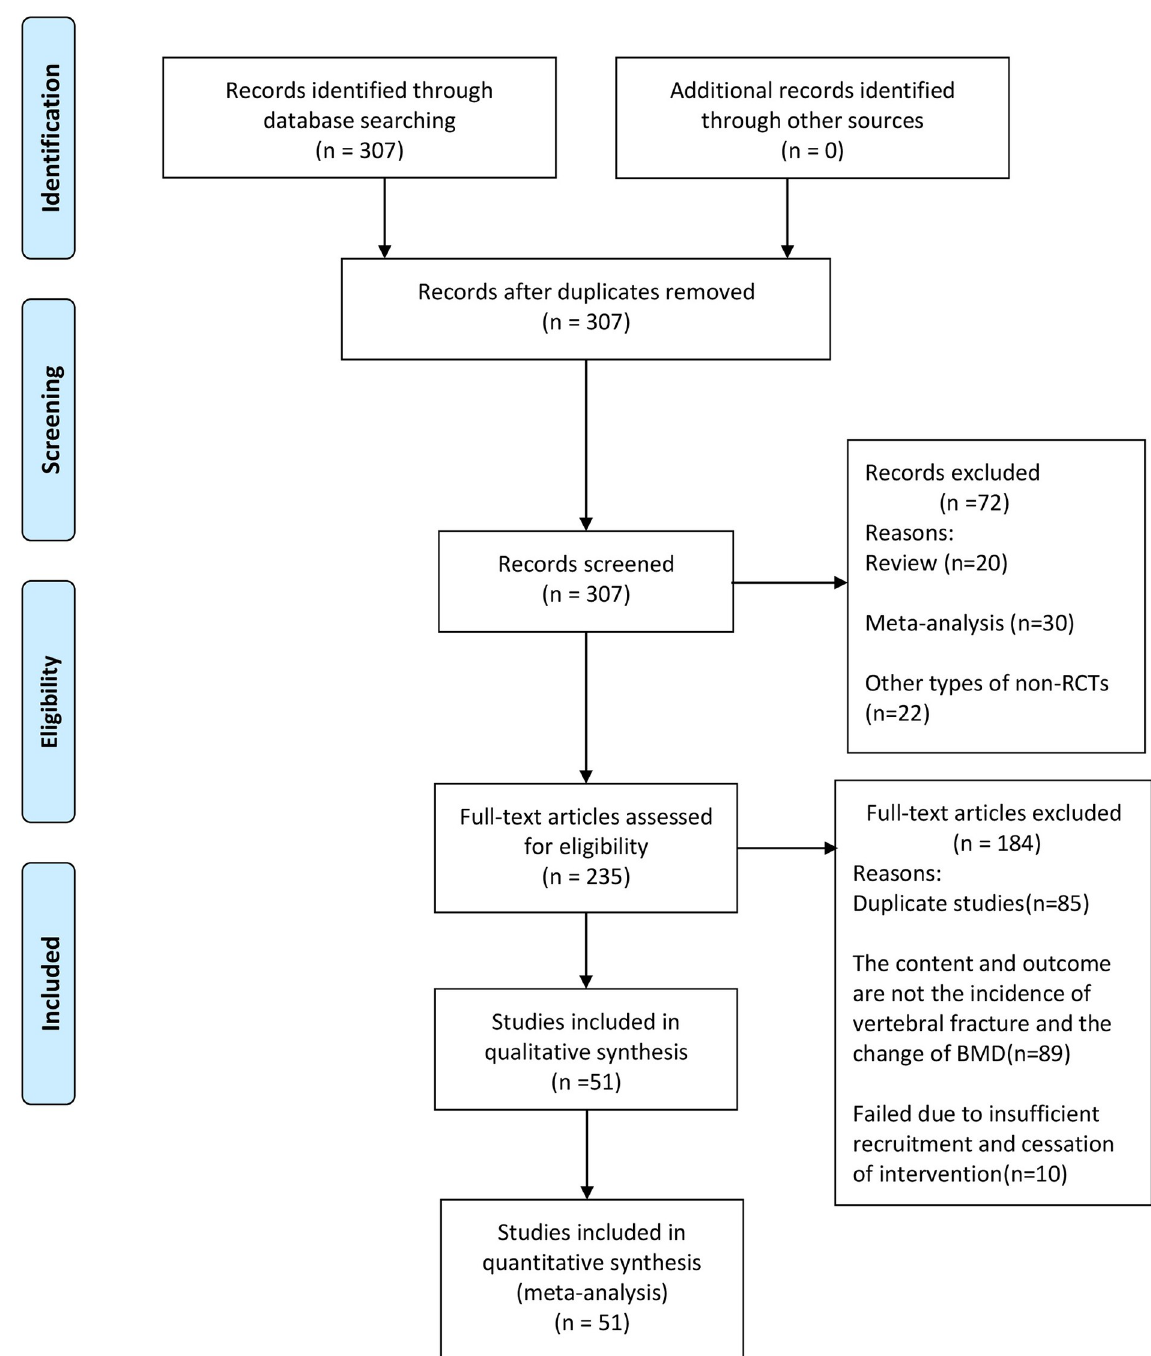
Fig 1. Flow diagram of literature search and study